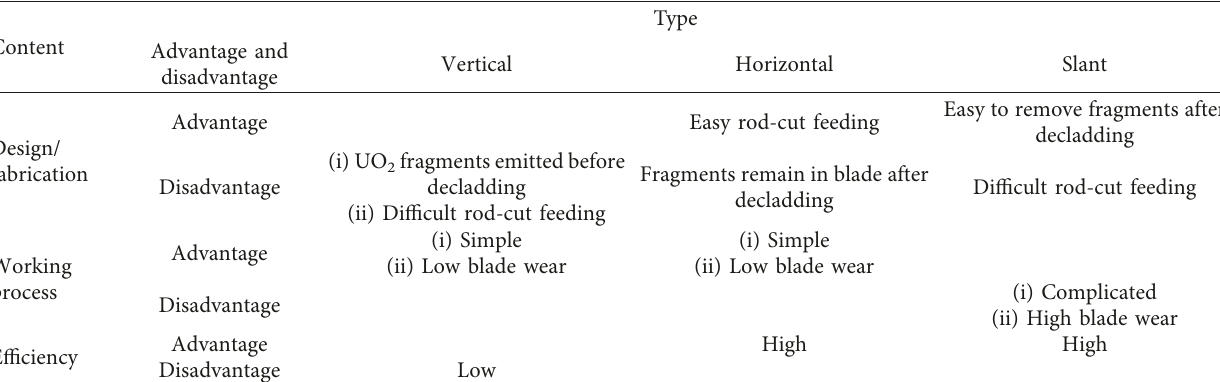
Table 2: Comparison of electric and hydraulic types for